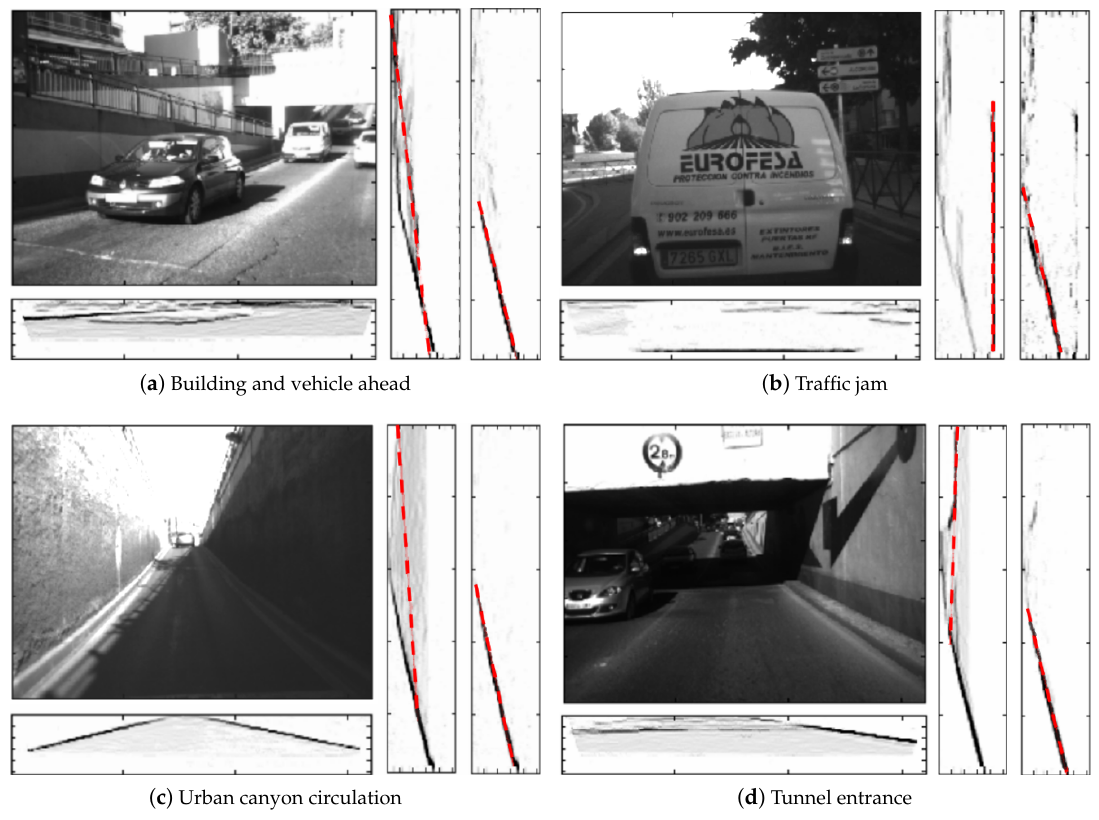
Figure 3. Examples of uv-disparity for different scenarios of interest in urban environments, where the left visible image, on the bottom the corresponding u-disparity, and right, the v-disparity and the v-disparity-free with the detection of the road profile (dashed red line), are